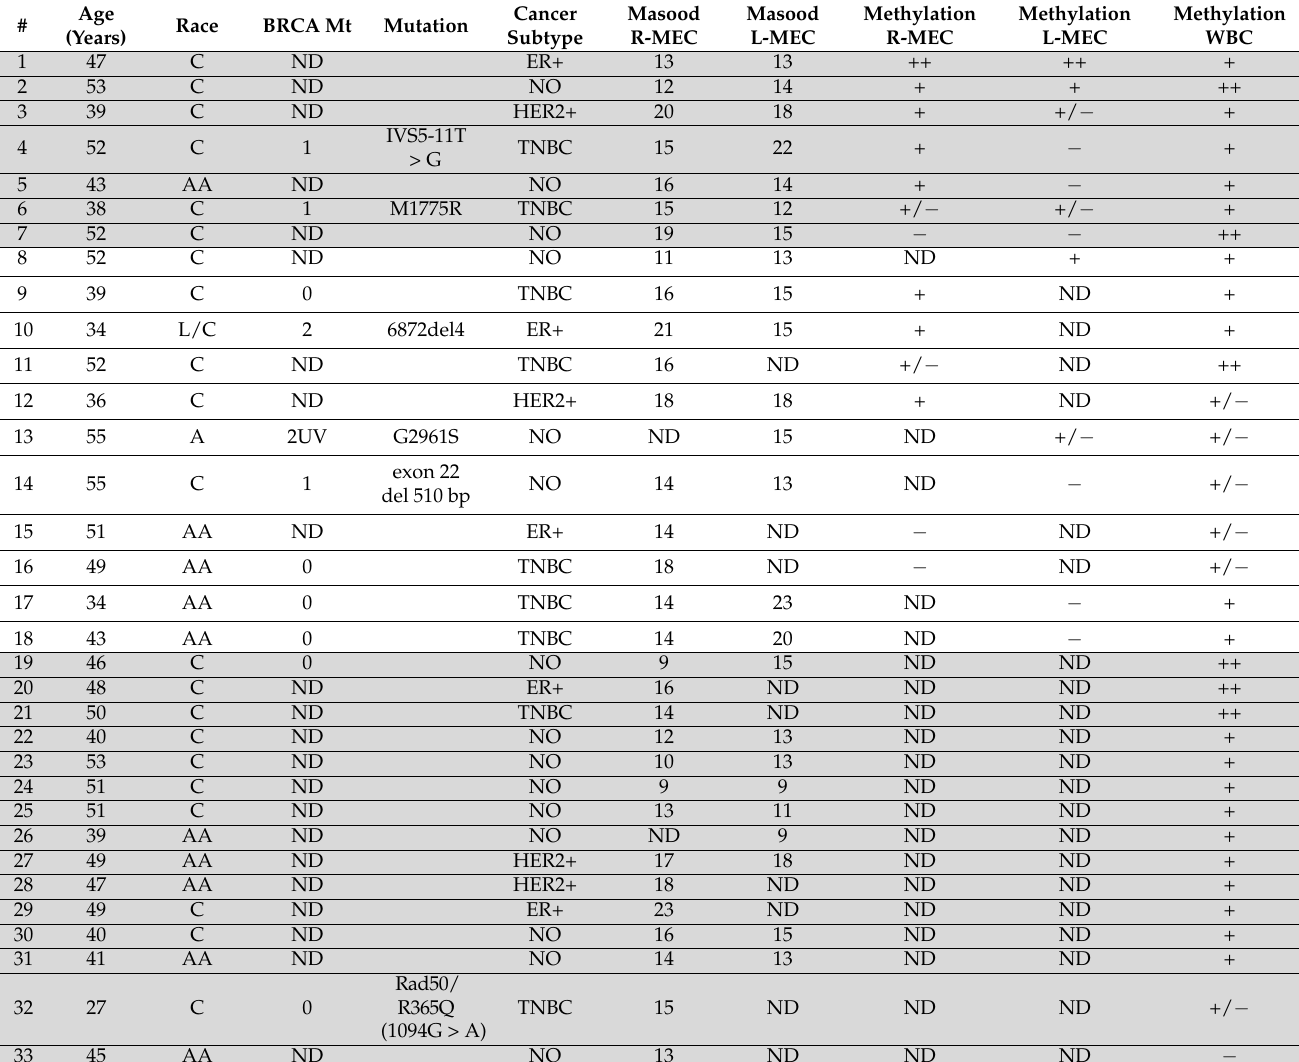
Table 3. Analysis of KCNK9 -US1 DMR methylation in mammary epithelial cells and white blood cells obtained from women ranging in age from 36 to